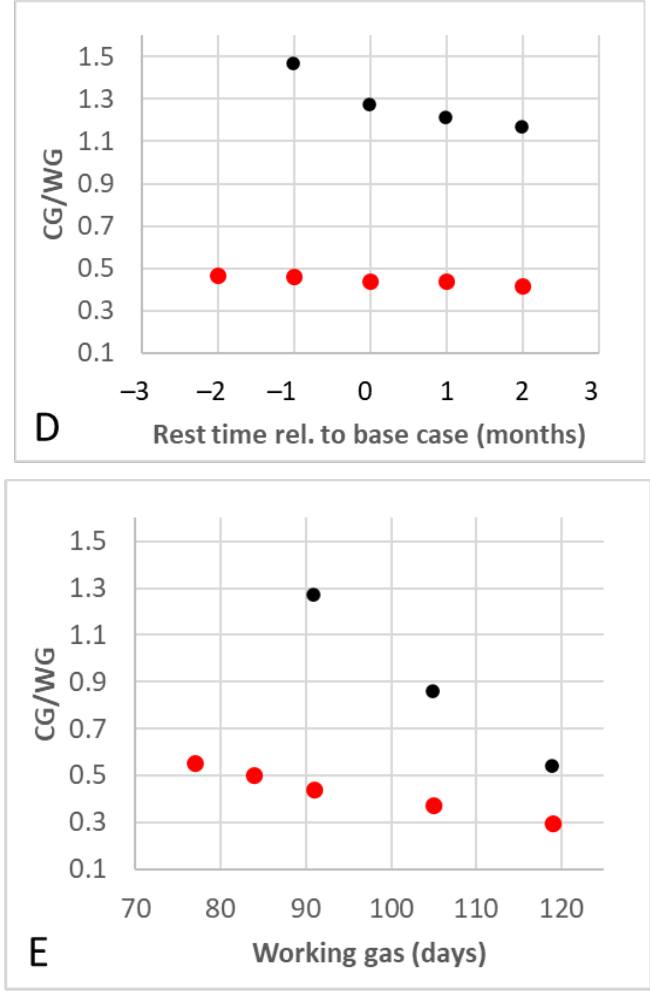
Figure 3. The figure shows the results of the sensitivity tests. The impact of five technical optimisation strategies was tested: ( A ) perforation length, ( B ) well size, ( C ) working gas volume, ( D ) rest time and ( E ) injection and production duration. The black circles show the “best case” injection performance, and the red circles show the “best case” production performance.